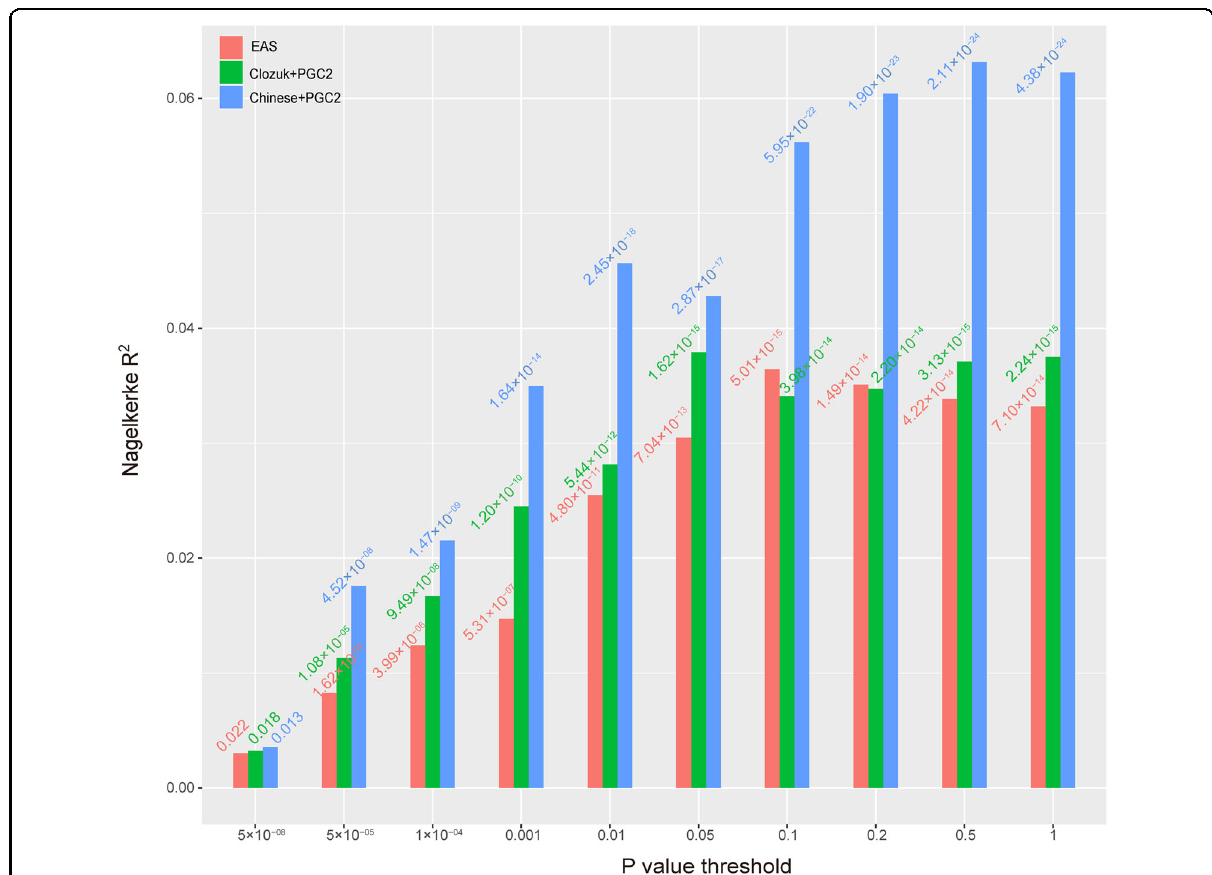
Fig. 4 Genetic risk prediction accuracy in subgroup 1 EOS cases and controls (discovery stage) using different training sets. PRSs were computed using GWAS summary statistics from three training sets. The red plot represents PRS result from EAS training set (including 22,778 SCZ cases and 35,362 controls). The green plot represents PRS result from CLOZUK + PGC2 training set (including 40,675 SCZ cases and 64,643 controls). The blue plot represents PRS result from Chinese + PGC2 training set (including 43,175 SCZ cases and 65,166